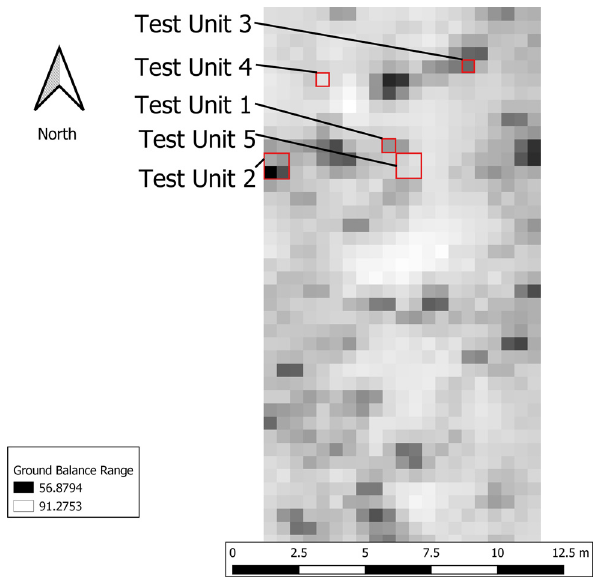
Figure 4: Interpolation map of the Grace Park survey area with test unit locations and assigned numbers in